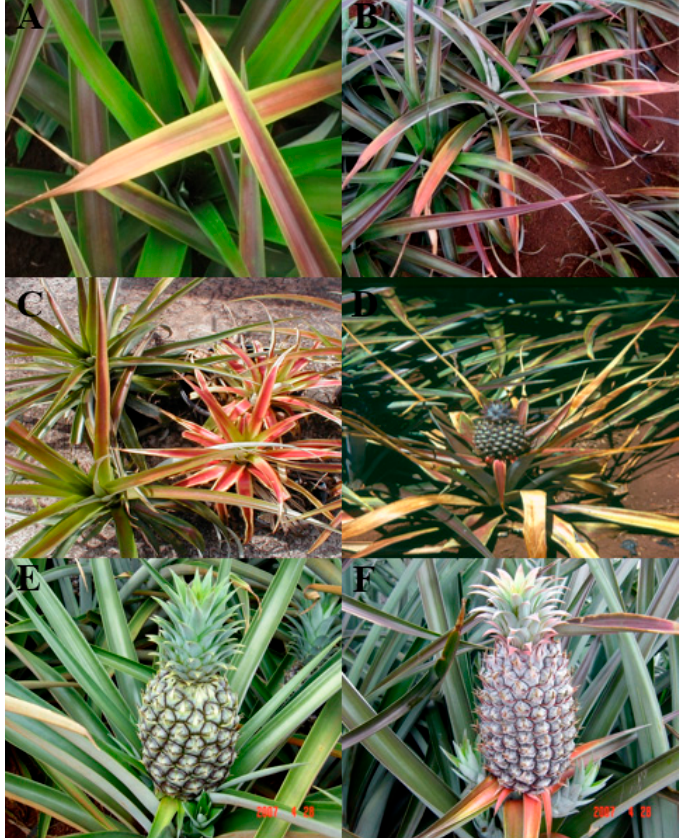
Figure 1. Symptoms of mealybug wilt disease in commercial pineapple hybrids and traditional Smooth Cayenne “Champaka” cultivar. ( A ) Pineapple Research Institute (PRI) hybrid 73–114; ( B ) PRI 73–50; ( C ) typical symptoms, including reddening of leaves with downward curling of margin tips, leaf-tip dieback; ( D ) and pronounced wilting of mature leaves. ( E ) Hybrid variety PRI 73-114, and ( F ) hybrid variety PRI 73–50.